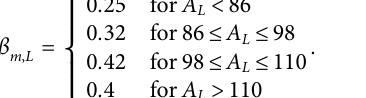
Frontiers in Physics |